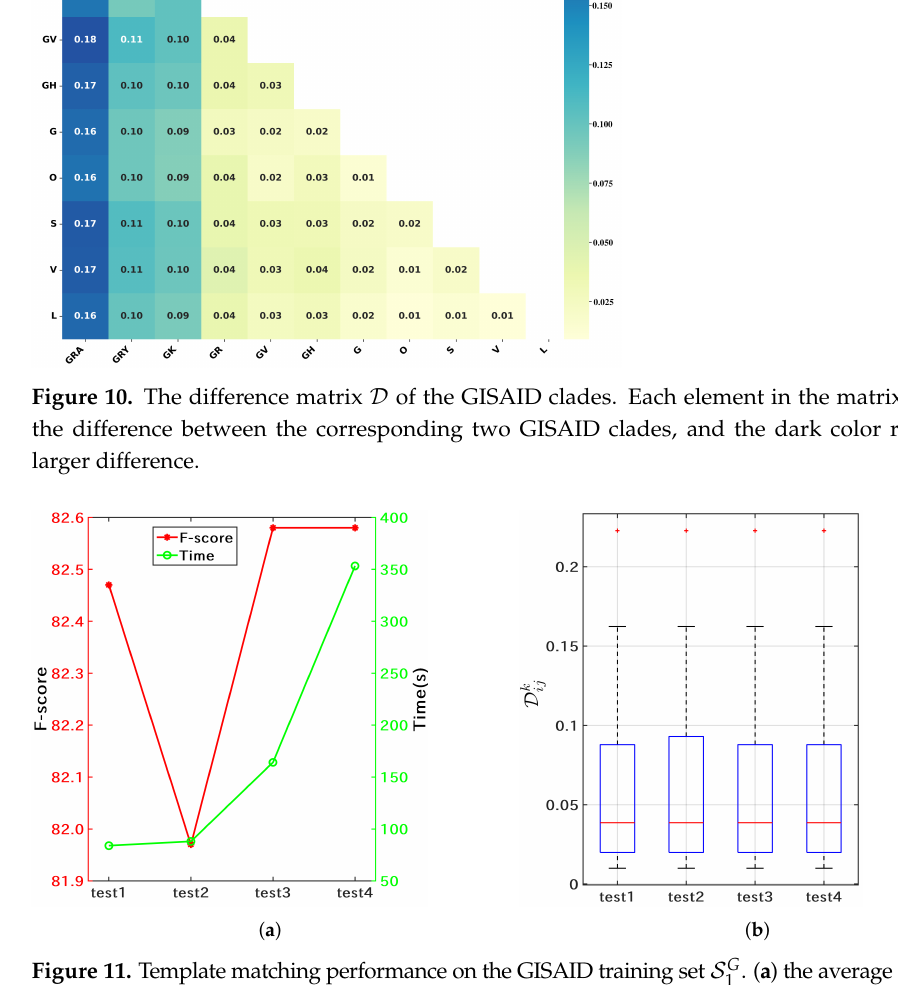
. ( a ) the average F-score (red) 1